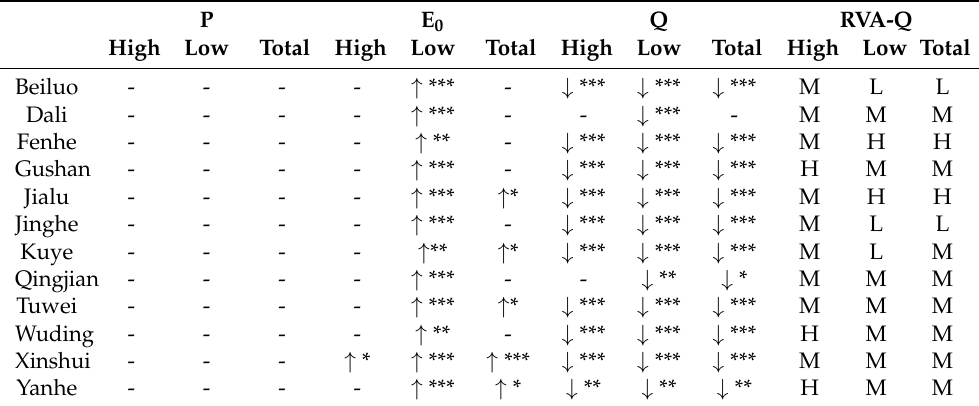
Table 4. Results of the Mann–Kendall test and RVA